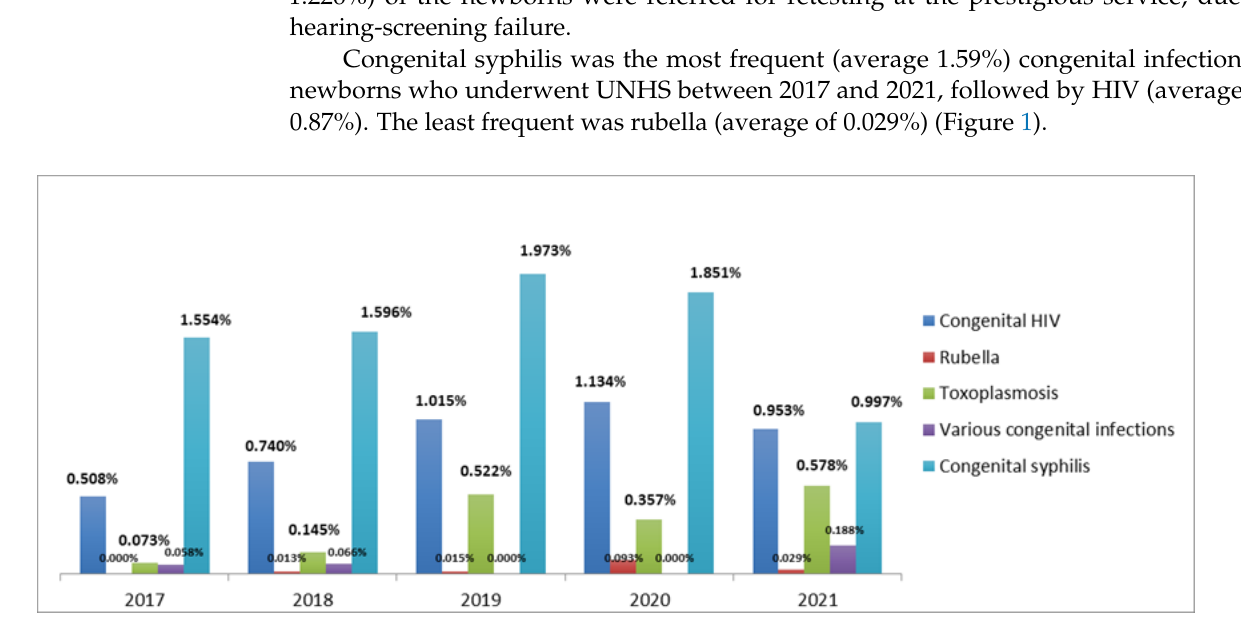
Figure 1. Relative frequencies of congenital infections in newborns who underwent UNHS, by year of birth. Florianópolis, SC, 2017 to 2021 (n = 34,801).